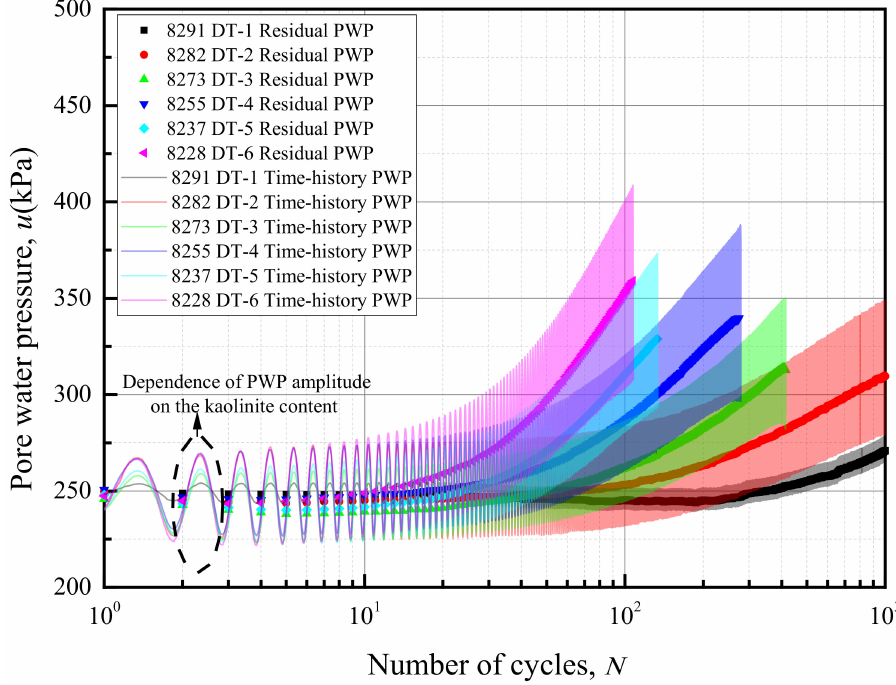
Figure 9. Relationship between number of cycles versus residual pore water pressure (deviatoric stress is zero at each cycle) and time-history pore water pressure for the mineral composition of artificial marine